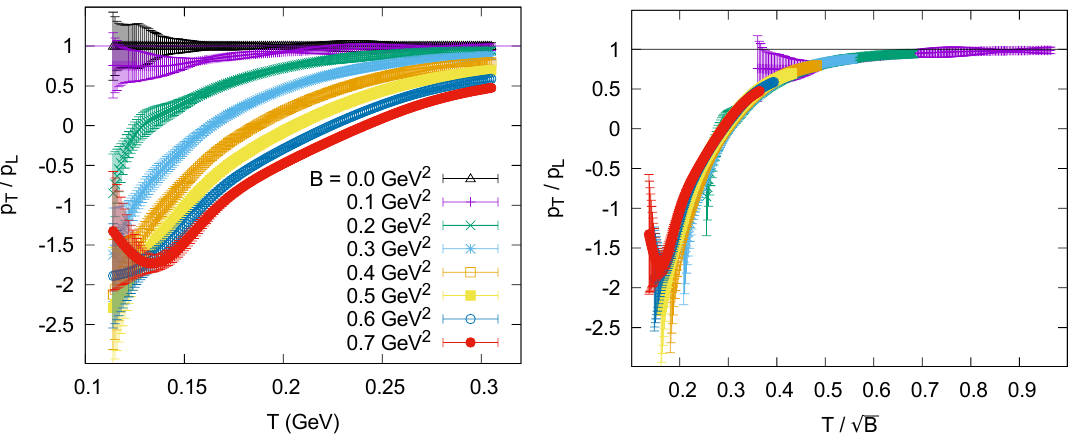
Figure 1 . The ratio R (cid:17) p T =p L of transverse to longitudinal pressure in QCD, de(cid:12)ned with renormalization point (cid:22) = (cid:3) H , for various values of external magnetic (cid:12)eld B . (See section 3 for details.) Left panel: R plotted as a function of T . Right panel: R plotted as a function of T= The di(cid:11)erent colors indicate di(cid:11)erent values of the magnetic (cid:12)eld and are identical in the two